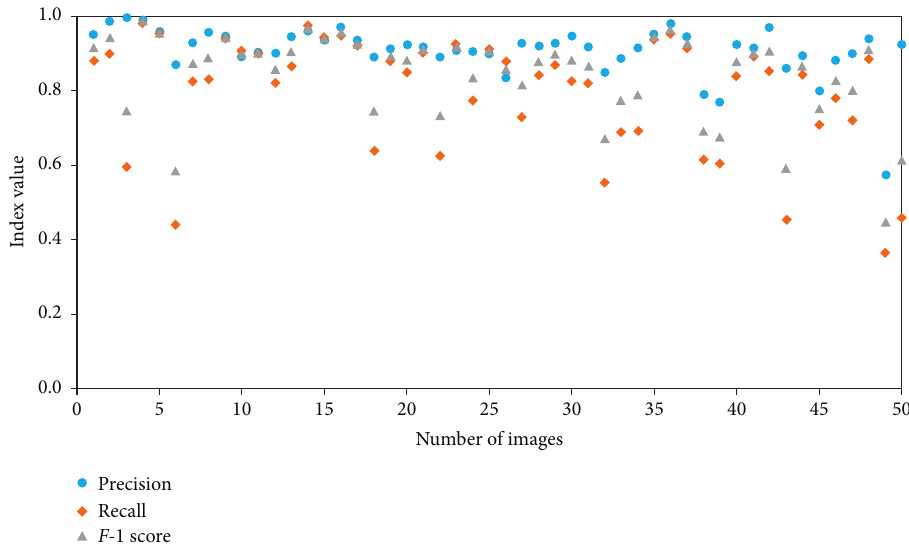
Figure 30: Three evaluation indexes of 50 images from the 200-dataset using the quadratic